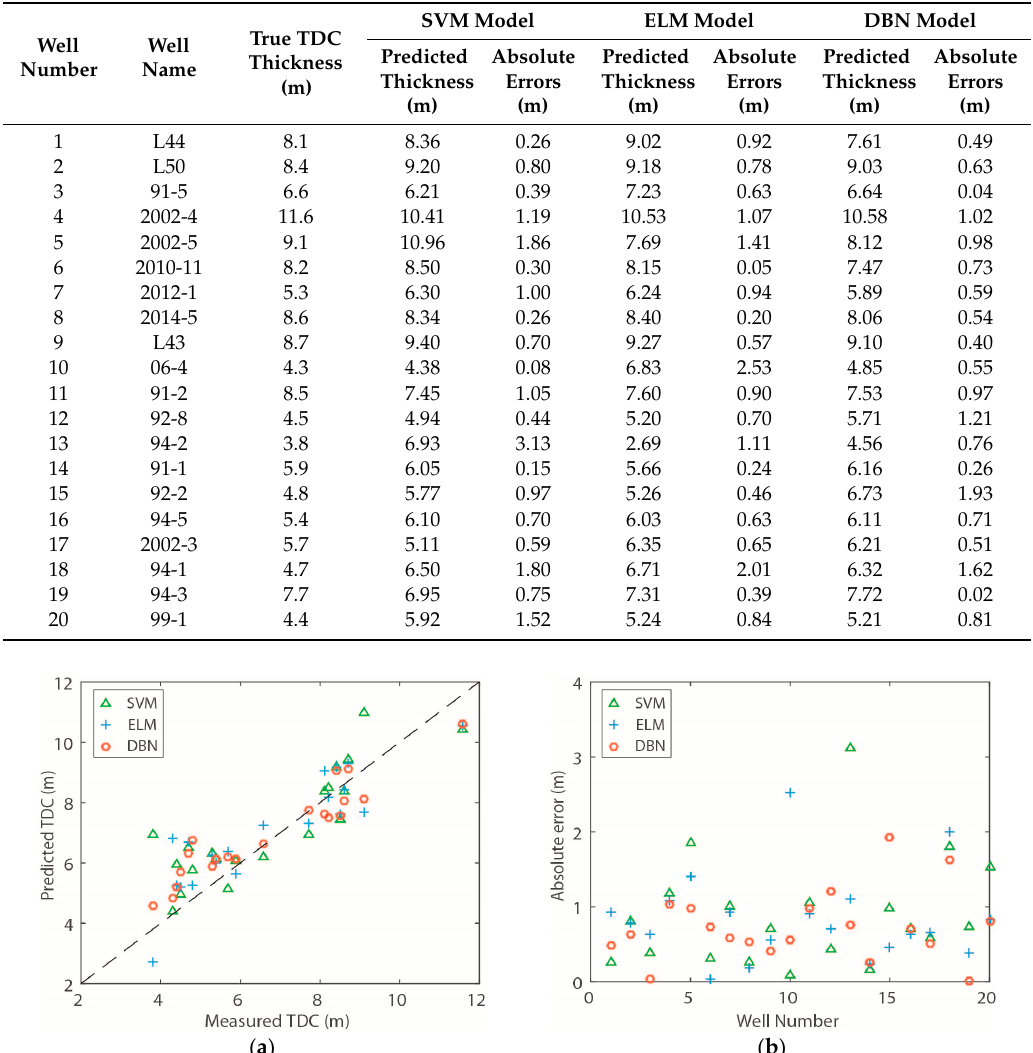
Table 6. Accuracy comparison of the predicted TDC thicknesses.